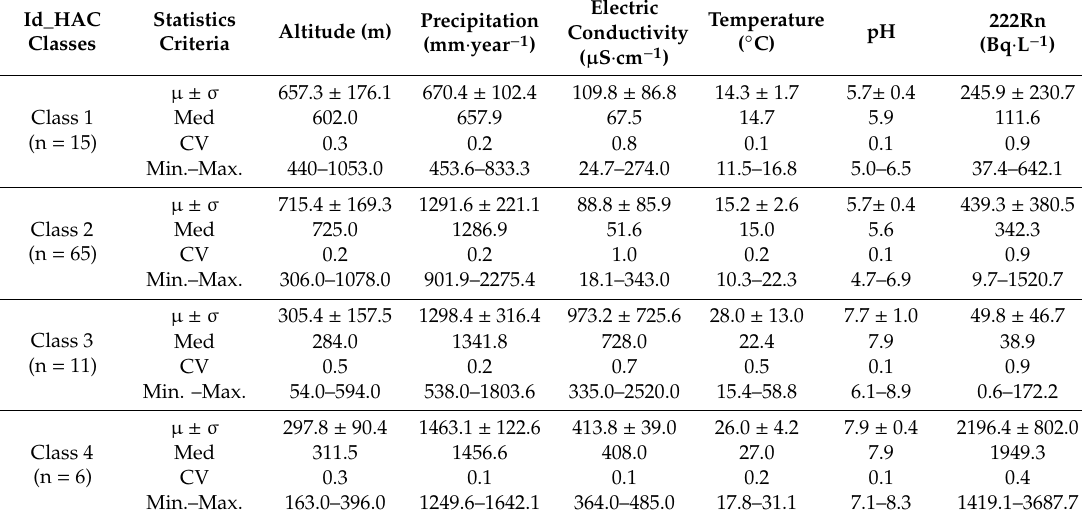
Table 2. Descriptive statistics for climatic, topographic, and physical-chemical hydrologic parameters of each HCA